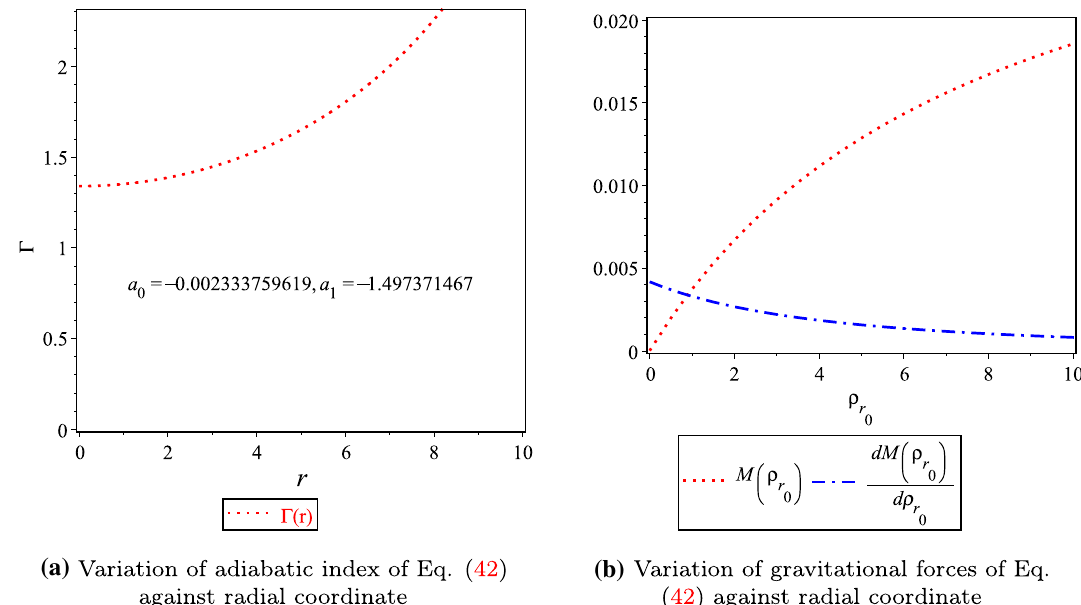
Fig. 13 Schematic plot of the radial coordinate r in the unit of km versus: a the adiabatic index of Eq. (42) which ensure that (cid:19) > 3 / 4, b the mass as a function of central density and its gradient w.r.t. central density for stellar 4U1608–52 ω ≥ 1 / 3 has (cid:19) ≥ 4 / 3 [69]. The problem of this model t familiar in the